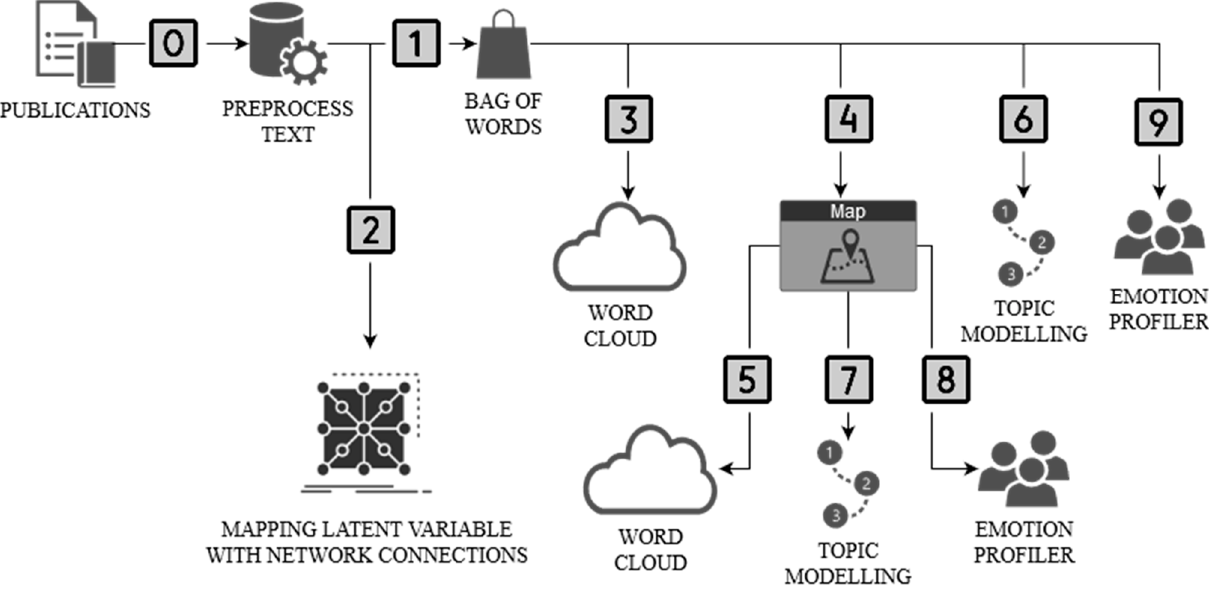
Figure 1. The framework of the authors’ research procedure (methodology). Source: own elabora- tion.